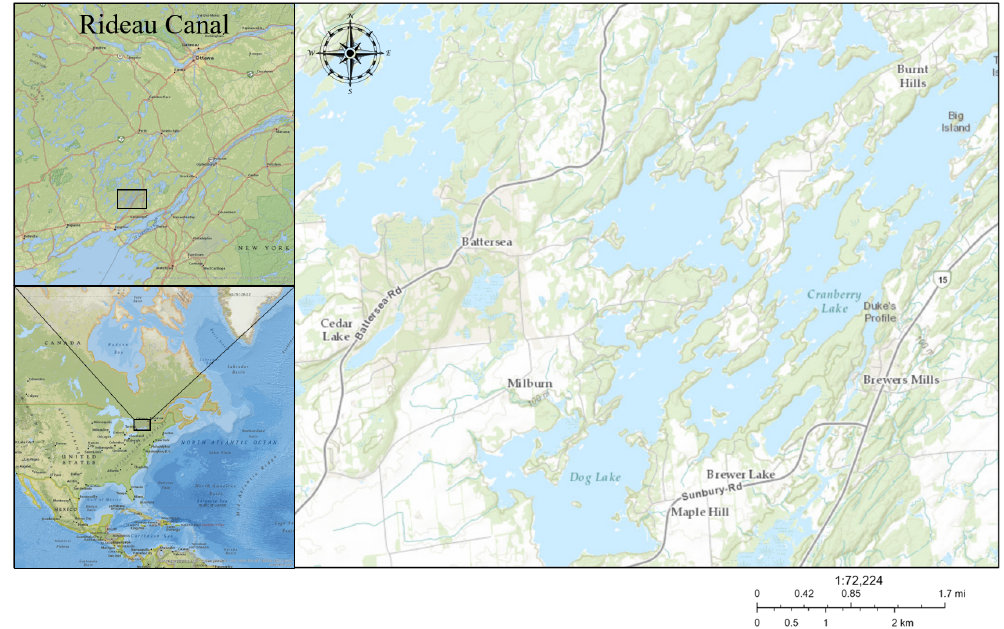
Figure 1. Map of Dog Lake, South Frontenac County, ON, Canada. The Rideau Canal watershed is shown in the top left while Eastern North America is shown in the bottom left. Dog Lake’s center basin is located at 44.435449° N, 76.345772° W.